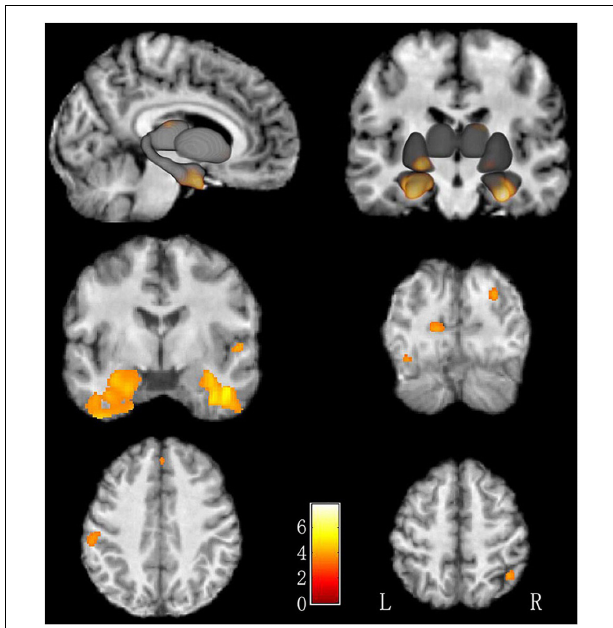
FIGURE 1 | Increased GMV in LBC relative to non-LBC. Increased gray matter volume was observed in the following regions (labeled in red-yellow): bilateral fusiform gyri, bilateral parahippocampal gyri, right superior parietal lobe, right thalamus, right superior occipital gyrus, left cuneus, right superior temporal gyrus, right medial prefrontal gyrus, left postcentral gyrus, left middle occipital gyrus, and left putamen in LBC relative to non-LBC.